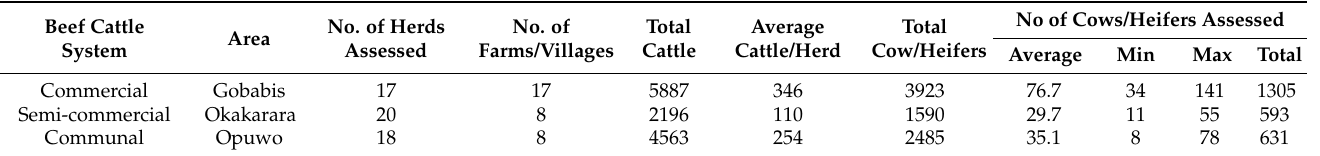
Table 1. Study areas for commercial, semi-commercial, and communal farming areas showing number of herds, farms/villages and number of cows